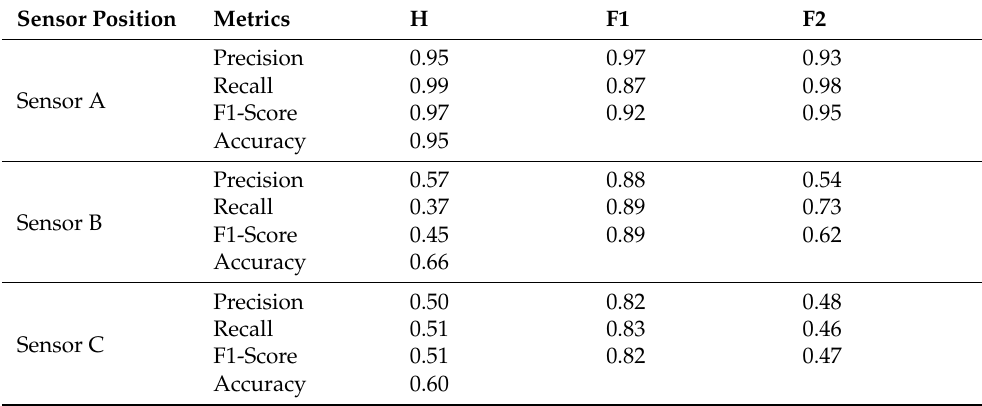
Figure 11. ANN training scores. Table 5. Performance evaluation of different sensor